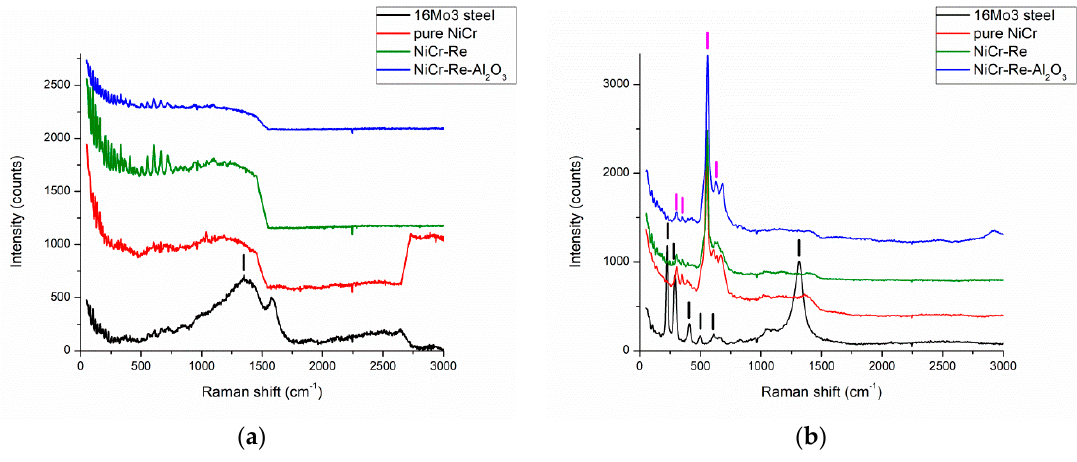
Figure 6. Raman spectra of ( a ) the samples before and ( b ) after the oxidation resistance tests.